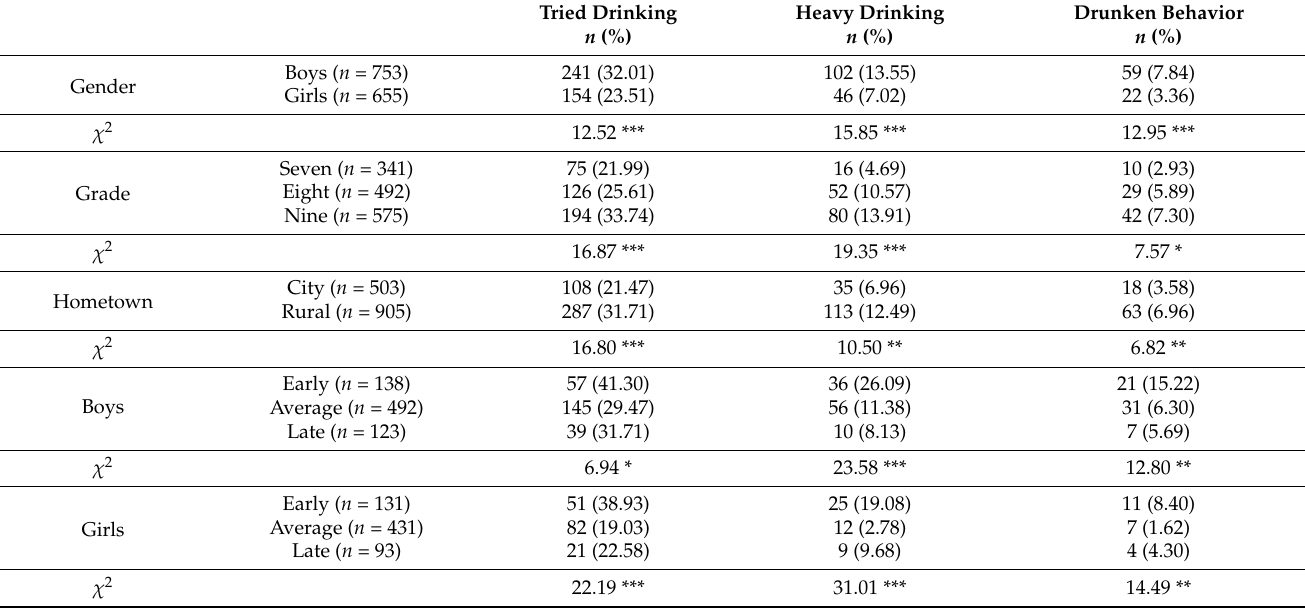
Table 2. Frequency (%) of the characteristics of adolescents by their drinking status and results of association ( n = 1408), and pubertal timing differences in drinking